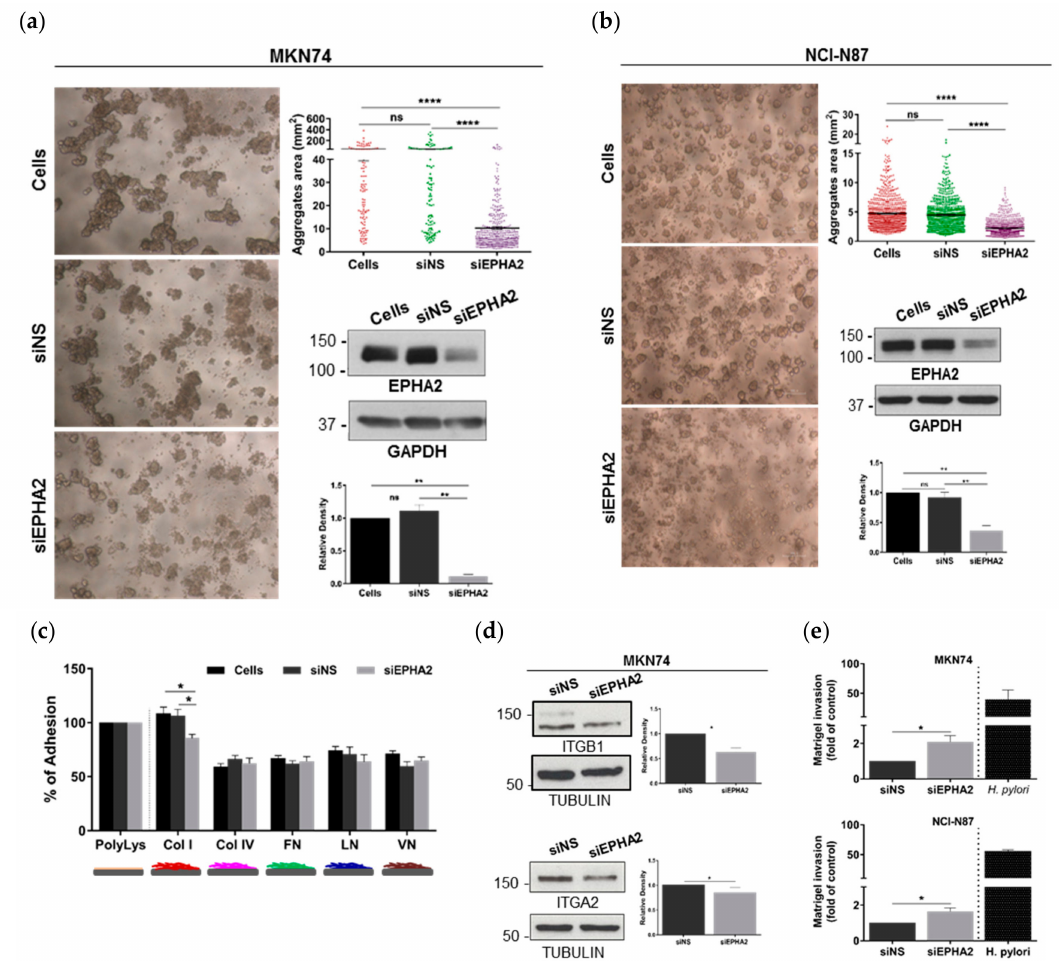
Figure 3. Role of EPHA2 in cell–cell and cell–matrix adhesion and invasion of gastric cells. Representative images of the slow aggregation assay for ( a ) MKN74 and ( b ) NCI-N87 gastric cells untreated (cells) transfected with a nonsilencing siRNA (siNS) or with a EPHA2 siRNA (siEPHA2); **** p < 0.0001, ** p < 0.01, ns—not significant ( p > 0.05). Cell–cell aggregate size quantification for each condition using Quantity One software. Representative Western blot of the EPHA2 protein expression and the densitometric quantification of the EPHA2 levels in all slow aggregation assays ( n = 4). ( c ) Cell–matrix adhesion of nontransfected siNS or siEPHA2-transfected MKN74 cells to di ff erent substrates using poly-L-lysine-coated cells as the maximal adhesion (100%); * p ≤ 0.05. ( d ) Protein expression of the integrins beta 1 (ITGB1) and alpha2 (ITGA2), a major receptor for collagen type I, assessed by Western blot and respective densitometric quantification ( n = 2); * p ≤ 0.05. ( e ) In vitro Matrigel invasion assay of MKN74 and NCI-N87 cells either transfected with siNS or siEPHA2 upon infection with H. pylori 26695 strain as a control; * p ≤ 0.05. Student’s t-test and one-way ANOVA with post-hoc Tukey’s